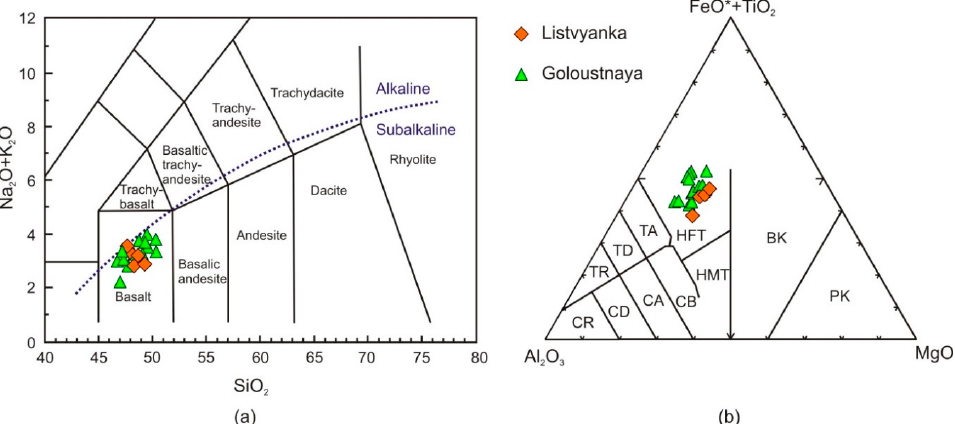
Figure 5. (Na 2 O + K 2 O)–SiO 2 diagram of LeBas et al. [34] ( a ); MgO–(FeO* + TiO 2 )–Al 2 O 3 diagram of Jensen [35] ( b ) for Listvyanka and Goloustnaya dolerites.